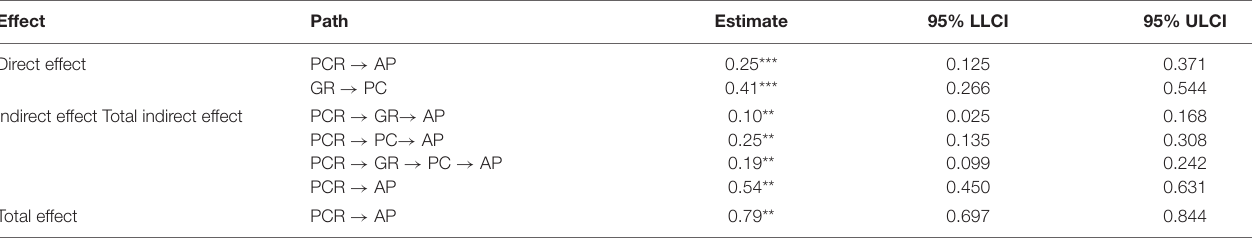
FIGURE 3 | Structural equation model of the influence of parent–child relationships, gratitude, and psychological capital on academic performance. PCR, parent-child relationships; AP, academic performance; GR, gratitude; PC, psychological capital; PCR1, active care; PCR2, self-disclosure; PCR3, family activities; PCR4, economic communication; GR1, perception and experience of social favors; GR2, expressing and reciprocating from natural favors; GR3, perception and experience of natural favors; GR4, expressing and reciprocating from others favors; GR5, expressing and reciprocating from social favors; PC1, self-confidence; PC2, tenacity; PC3, optimism; PC4, responsibility; AP1, learning efficiency; AP2, interpersonal promotion; AP3, learning dedication; AP4, objective achievement. ** p < 0.01 *** p < 0.001. TABLE 7 | Results of the bootstrap